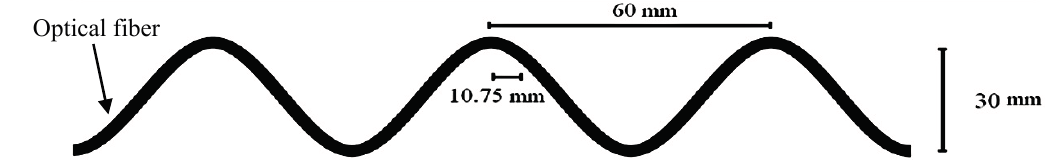
Figure 3. Diagram of bending radius in fiber